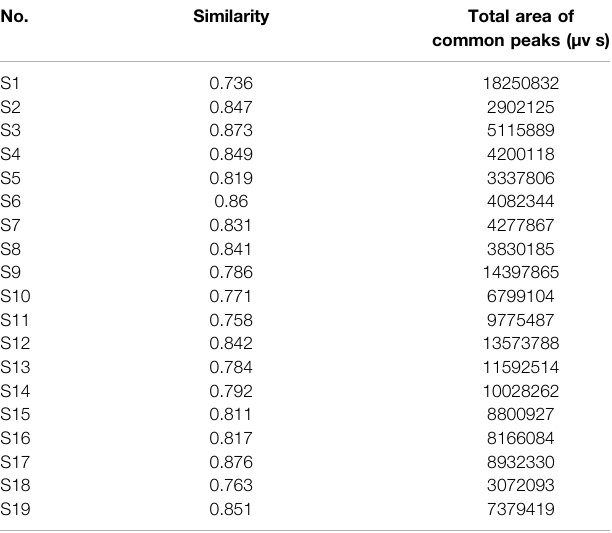
TABLE 3 | The similarity of 19 batches of samples.